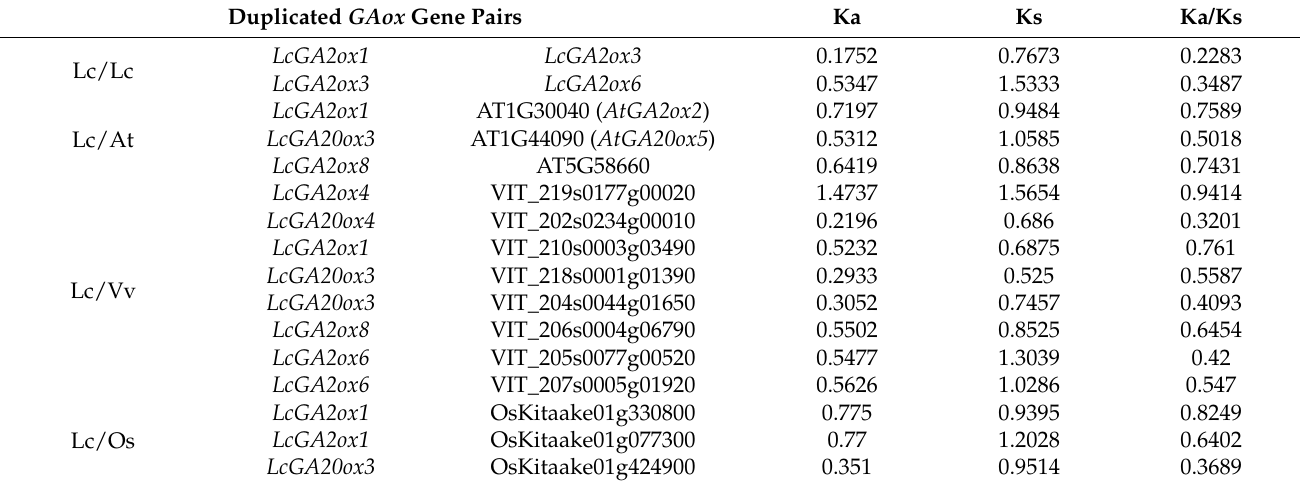
Table 3. The orthologous gene pairs’ Ka/Ks ratios among four